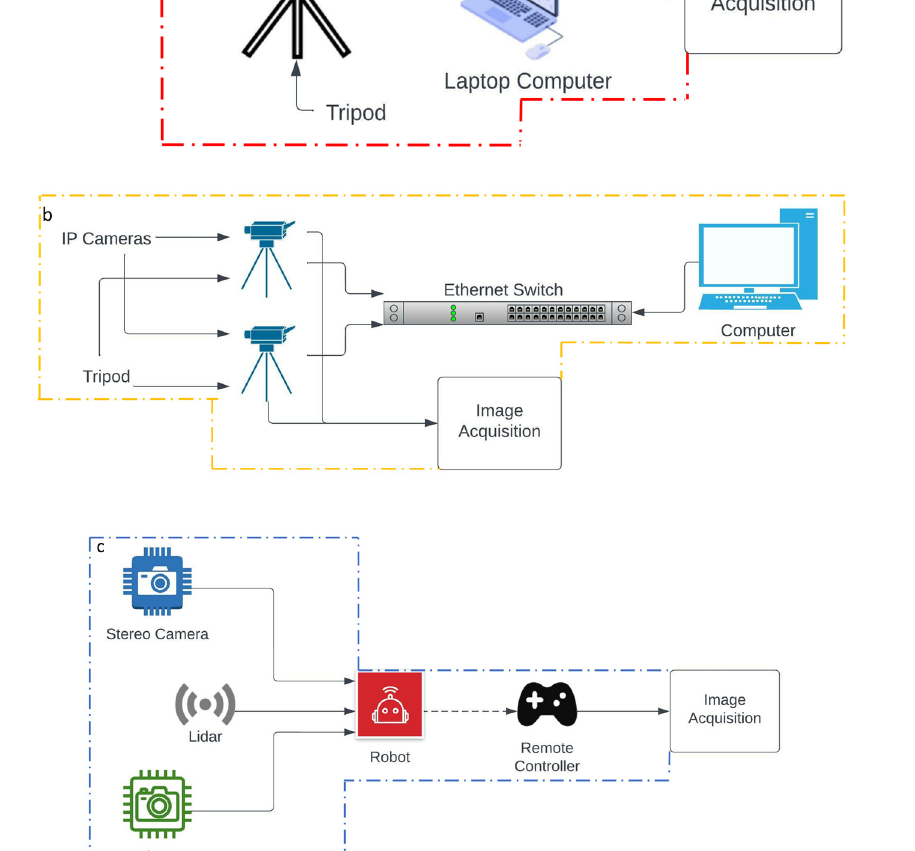
Figure 3. Implementation of image-based devices and systems. ( a ) 2D vision system for digital im- age correlation; ( b ) 3D vision system for digital image correlation; ( c ) Novel inspection system using inspection robot; ( d ) UAV photogrammetry for displacement monitoring. 4.2.1. 2D Vision System for DIC A series of digital photographs taken of the surface of a structural component at var- ious loading stages are used in the full-field, non-contact structural sensing technique known as DIC, to reveal deformation patterns between the photos [47]. This setup is a non-destructive method for SHM that utilizes image and video capturing devices. According to the study of [58], the 2D system, shown in Figure 3a, is placed near a ground floor window of a building adjacent to the region of interest and capturing it from the side of the pedestrian bridge. The camera for the 2D vision system was located 13 m away from the monitored area to capture 140 cm of the bridge’s length. Note that the location of the camera for such a 2D vision system must be established properly, so the line of sight is not obstructed by any means, before proceeding to image acquisition. Ad- ditionally, the camera can also be adjusted with different angles, distances, and framer- ates, as conducted in the study of [10]. A Canon VIXIA HF R42 camcorder can be used to begin measuring the deformations of an object that was perfectly still for a series of pre- determined distances. Using a 2D vision system, the result is nearly indistinguishable from using vibration devices to track the displacement of a particular structure.